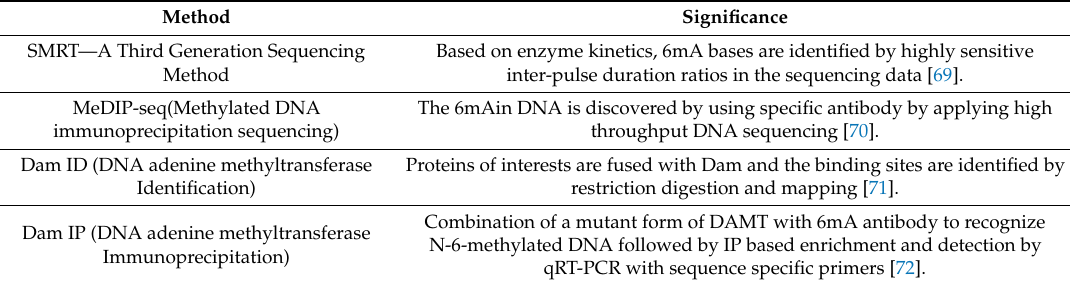
Table 2. Various 6mA detection methods and their